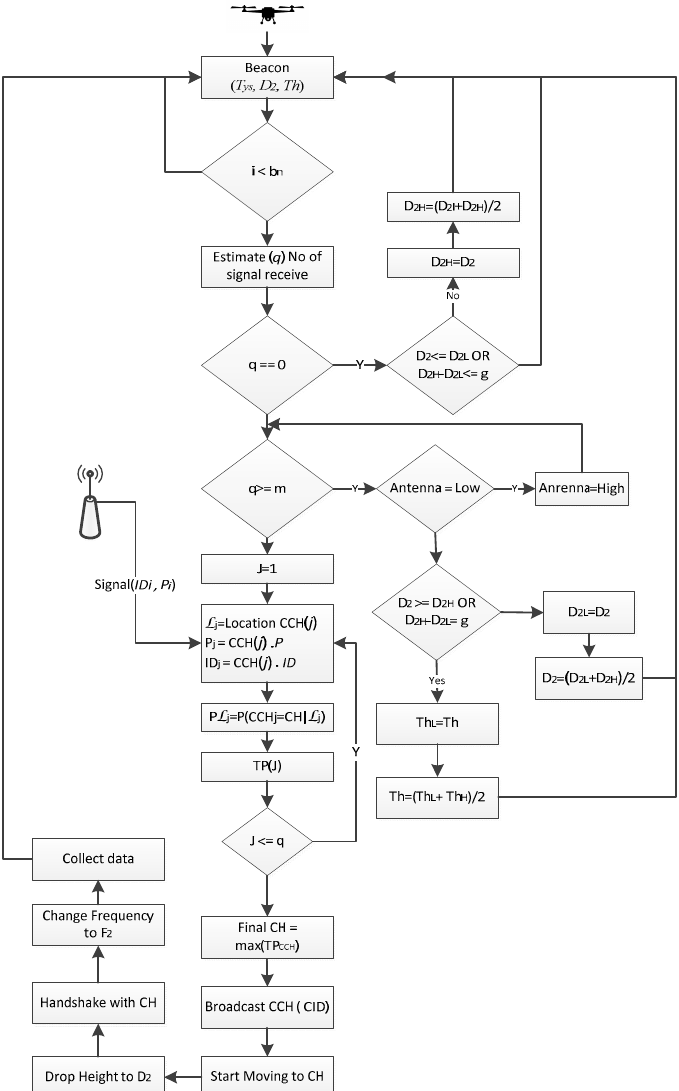
Figure 2. Flow chart of the UAV working.